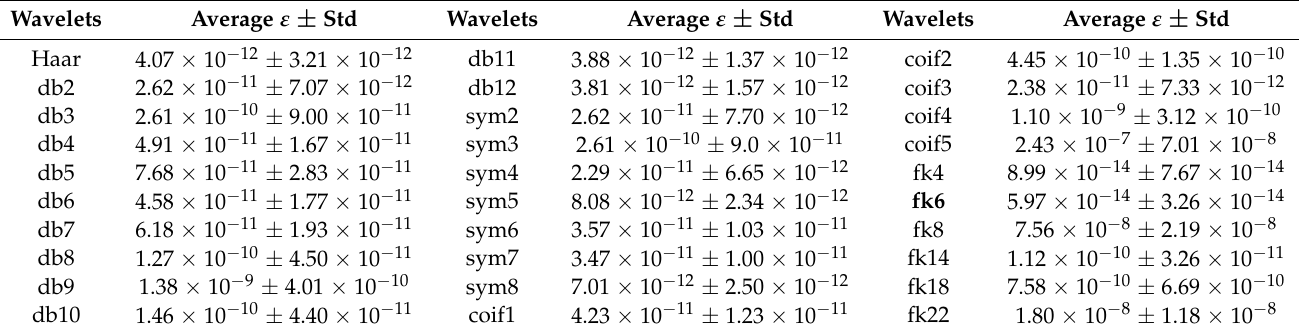
Table 3. Wavelets vs. average reconstruction error.